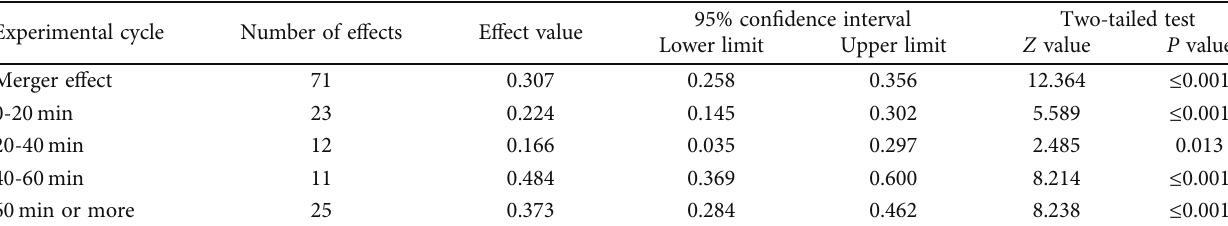
Table 6: E ff ects of di ff erent experimental